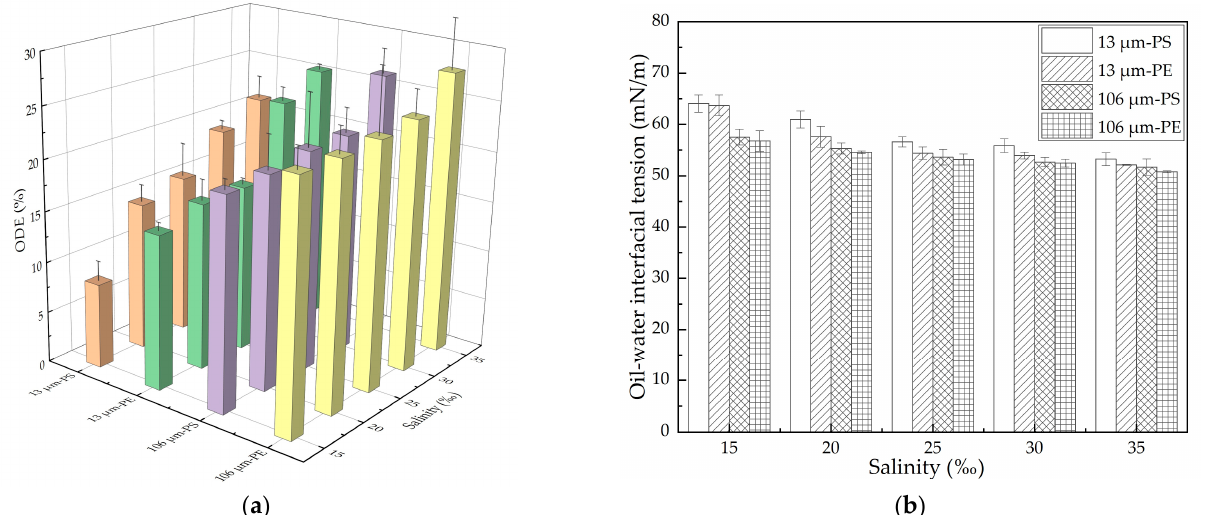
Figure 2. Impact of salinity on oil dispersion in the presence of different MPs in the oscillation experiment: ( a ) ODE ; ( b ) Oil–water interfacial tension. The error bar represents the standard deviation of the measurements of the three parallel samples. Orange, green, purple and yellow indicate 13 μ m-PS, 13 μ m-PE, 106 μ m-PS, 106 μ m-PE, represently.